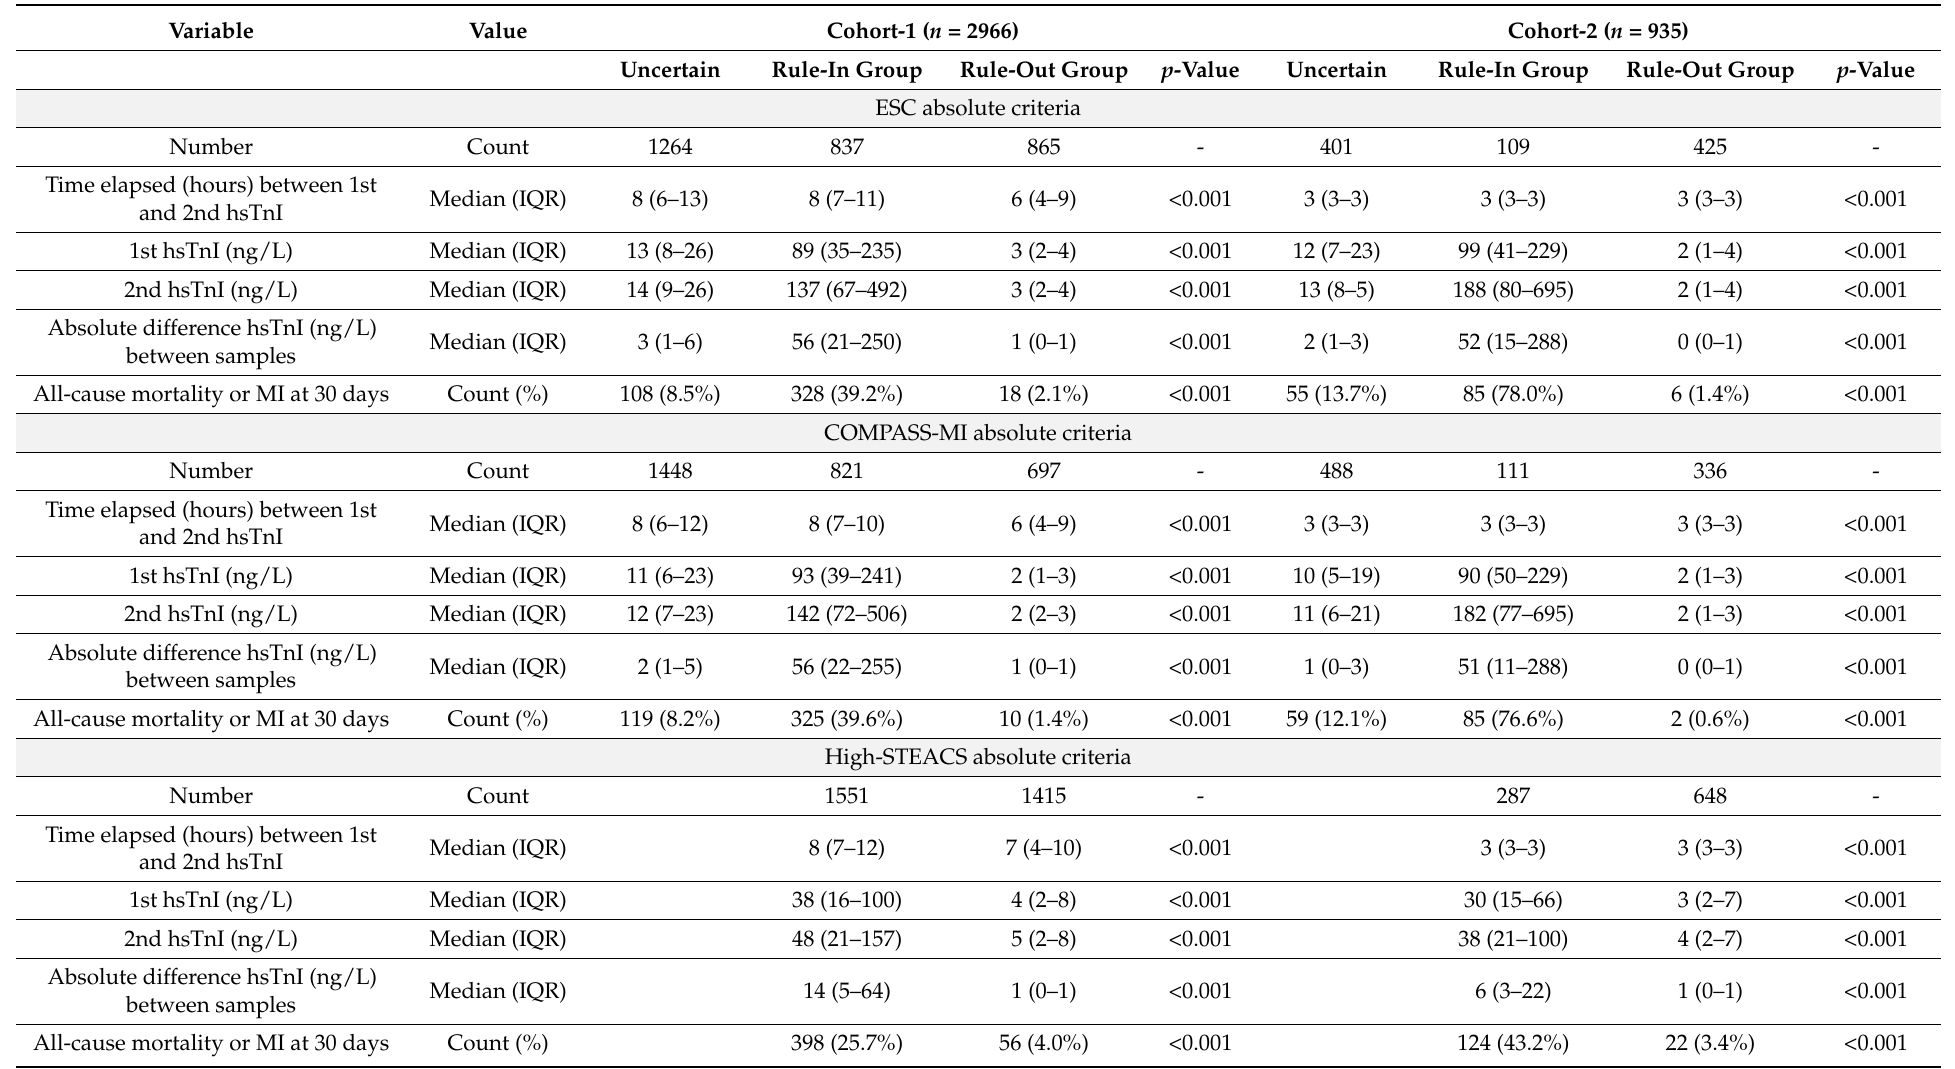
Table 3. The hs-cTnI levels and 30-day outcomes of the two ED cohorts characterized by the three hsTnI